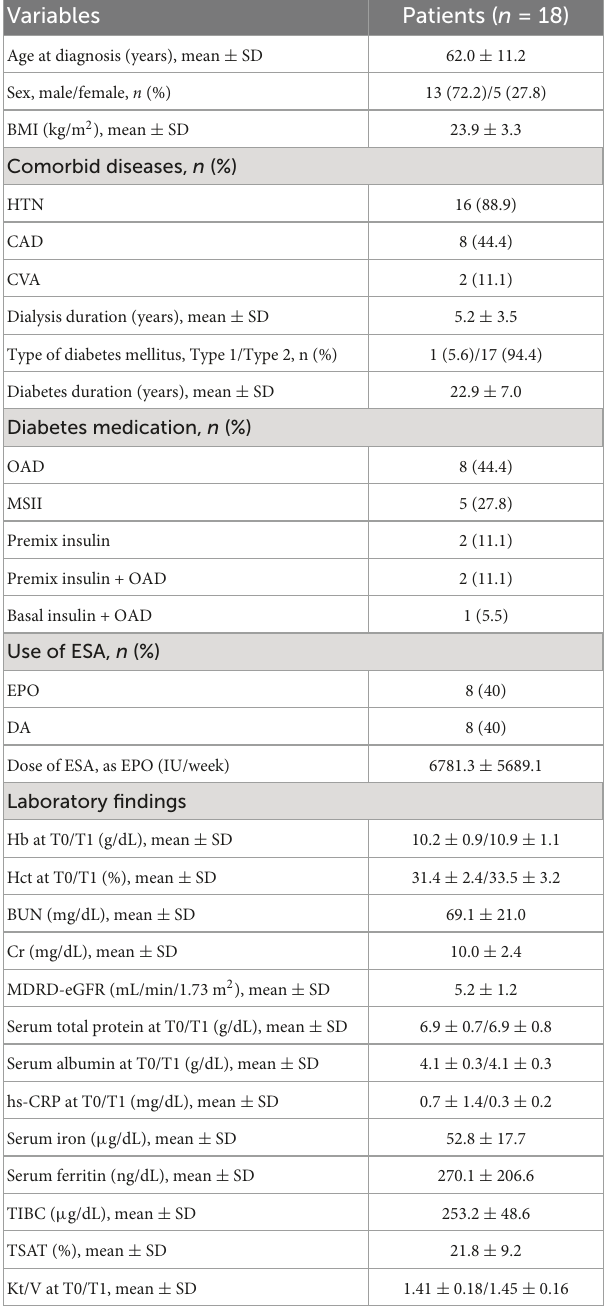
TABLE 1 Basic demographics and clinical